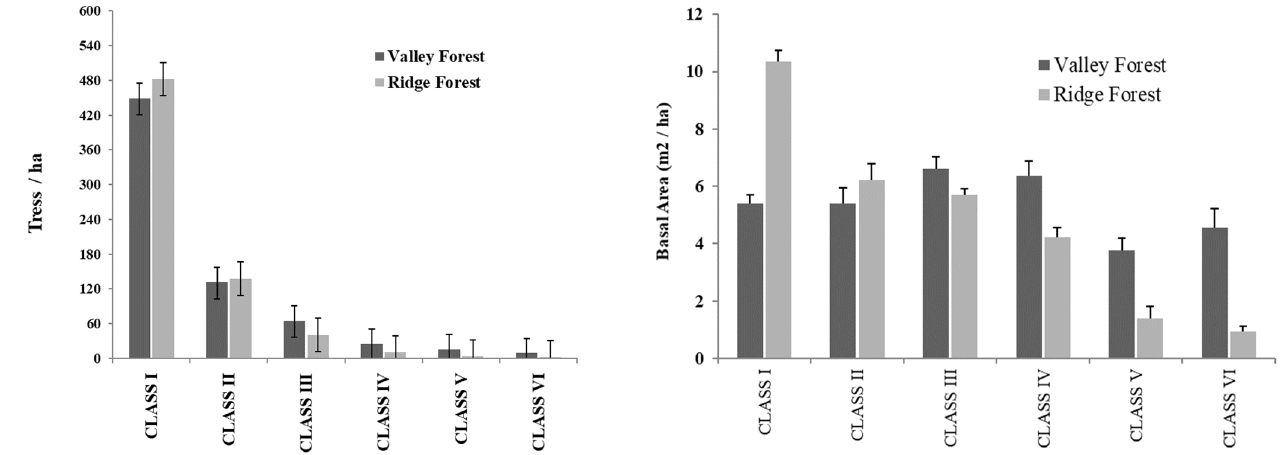
Figure 5. Average basal area ha − 1 and trees ha − 1 by diameter classes on each forest type.